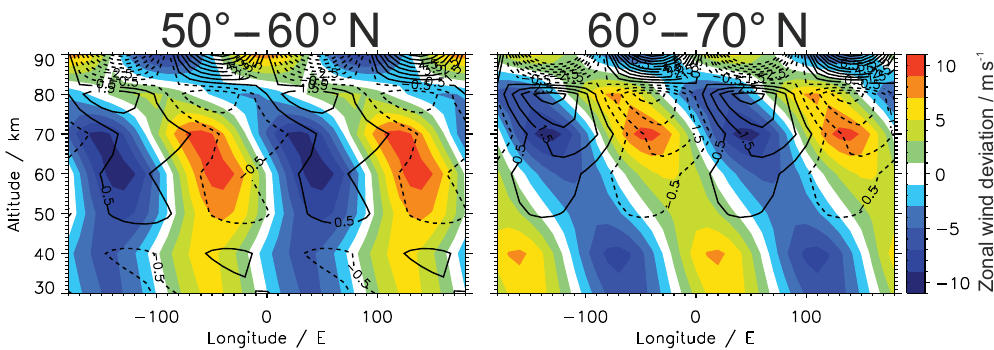
Figure 8. Longitude–altitude cross sections of the geostrophic zonal wind amplitude (colored contour) and the absolute GW drag amplitude in ms − 1 day − 1 (contour lines) in Period II. The plots show the deviation from the zonal mean of the wavenumber 2 filtered atmospheric wind component and GW drag. Data are derived from